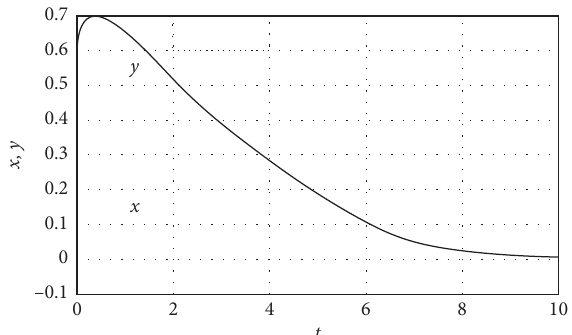
Figure 5: Dynamic evolution of government and enterprise strategy ( e